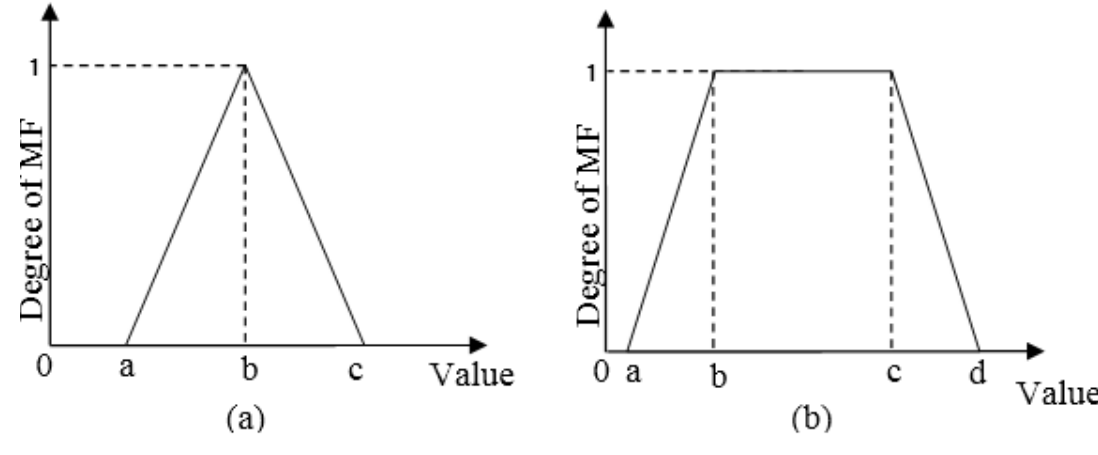
Figure 6. Input membership functions (MF) used for ANFIS design. ( a ) triangular MF; ( b ) trapezoidal MF.